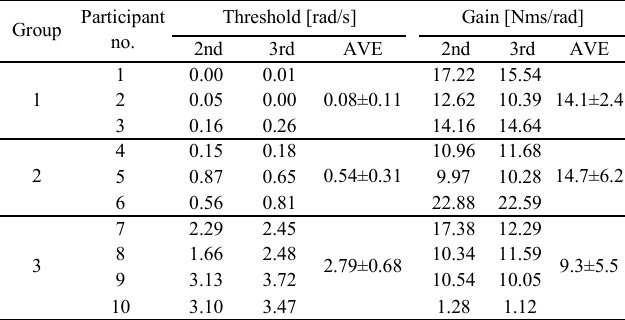
The identified muscle spindle model parameters (velocity thresholds and gains) for all participants are summarized in Table 4. The identified thresholds and gains were not different between the second and the third session (p=0.07 and p=0.25, respectively). This suggests that the second session had little effect on spastic properties in the third session. The threshold was statistically different (p<0.05), but the gain was not different (p=0.117) among the three groups. The thresholds were linearly correlated with the EMG duration and the peaks sum as r=-0.66 (p<0.01) and as r=-0.69 (p<0.01),